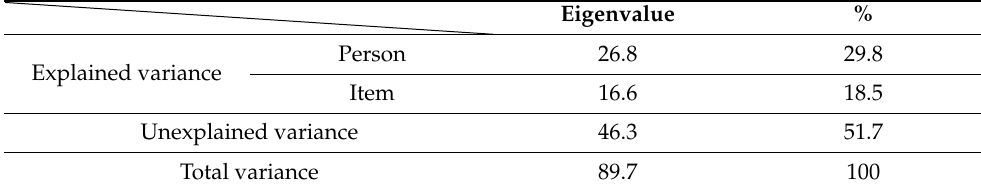
Table 5. Verification of